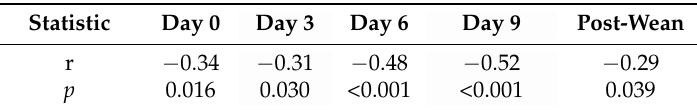
Table 4. Pearson’s correlations between order in which cattle were tested on day 9 and mean Flight Time (FT) on days 0, 3, 6, 9 and one month post